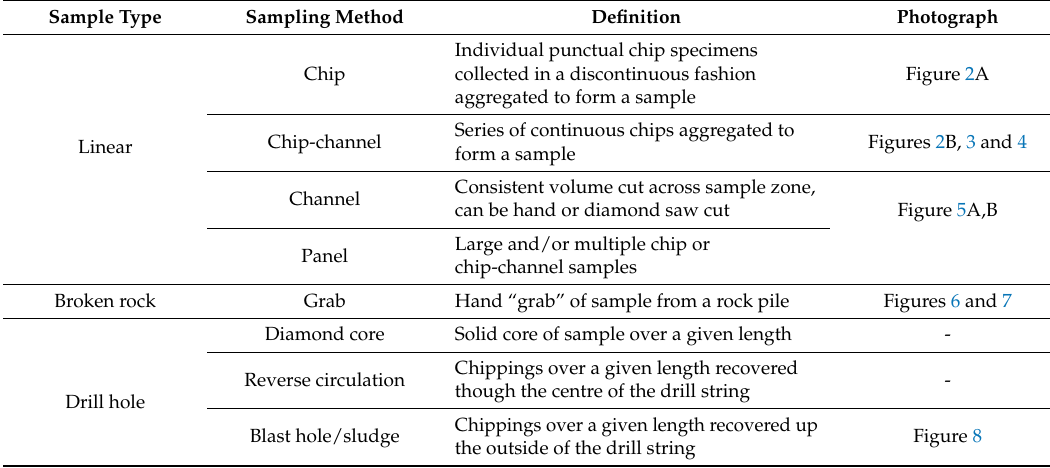
Table 6. Underground grade control sampling types and methods. Note, strictly drilling is a linear sampling method, though it is classified separately here as it is different from the main grade control